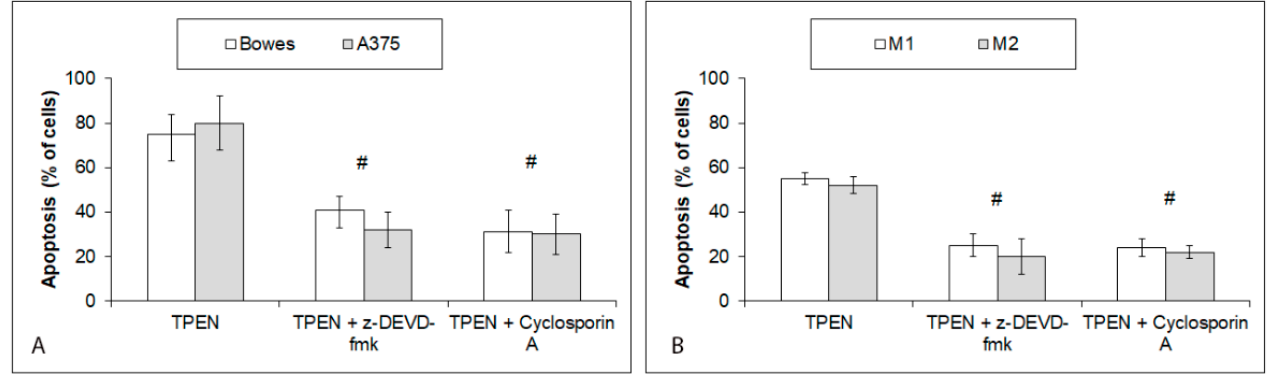
Figure 8. Effects of specific caspase-3 or cytochrome c mitochondrial release inhibition on 25 µM